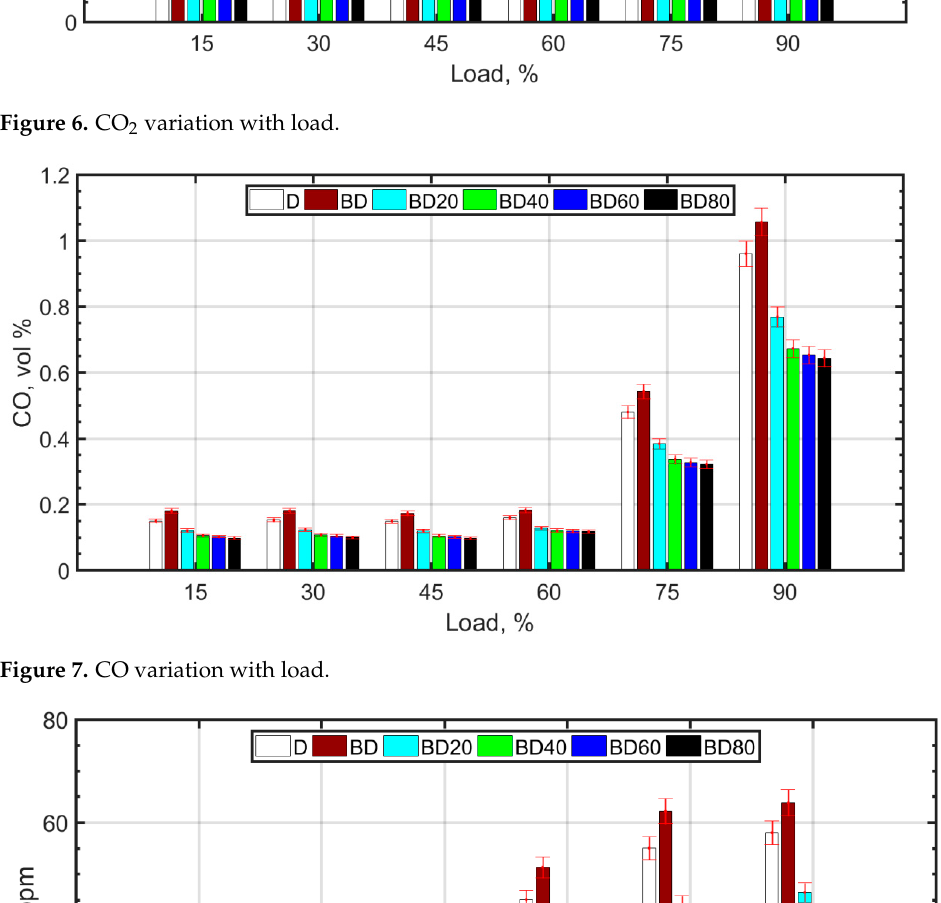
Figure 7. CO variation with load.